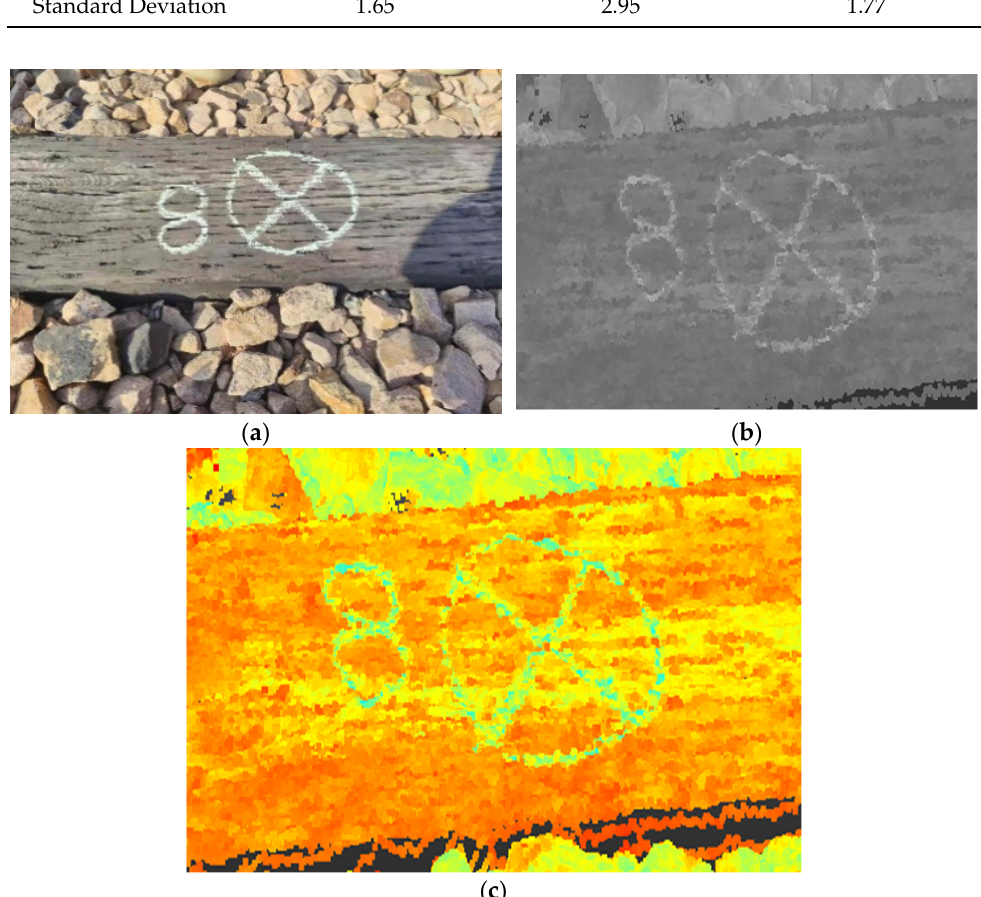
Figure 18. Control point signs in different images:( a ) Real scene image; ( b ) Grayscale image; ( c ) Intensity scale image.